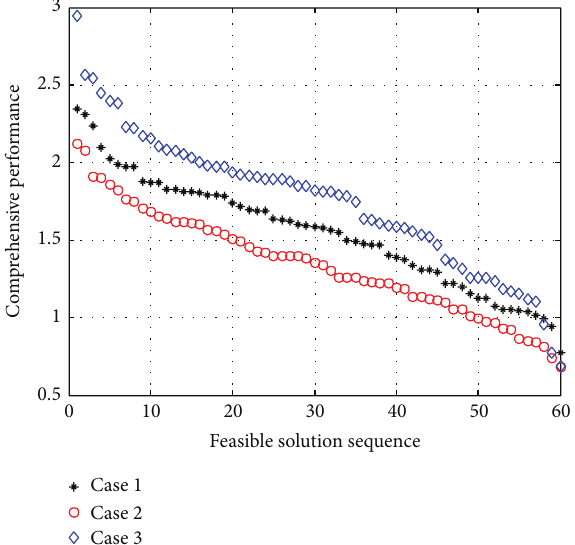
Figure 10: Comprehensive performance of selection schemes of design units, construction units, and suppliers in construction contractors according to the above three